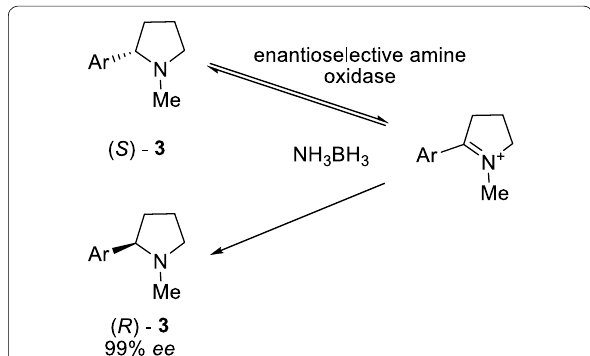
Fig. 3 Deracemization of racemic N -methyl-2-phenylpyrrolidine 3 to ( R )- N -methyl-2-phenylpyrrolidine by employing a sequence of